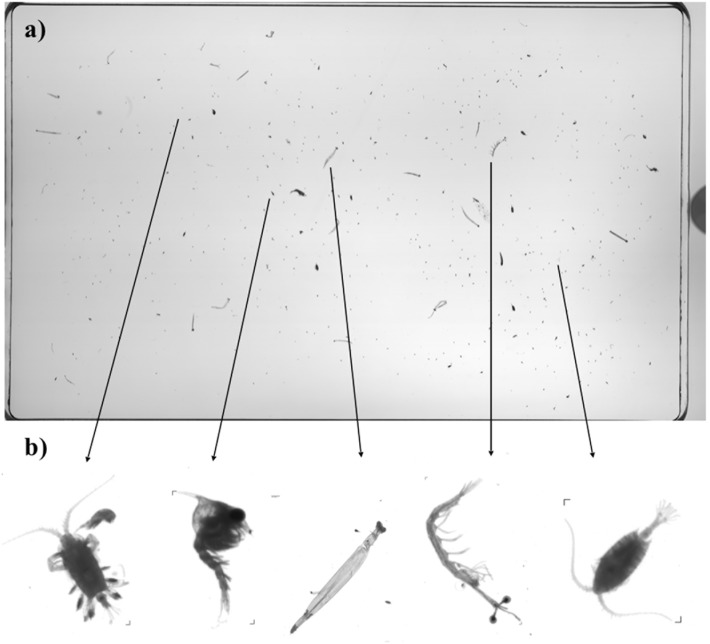
ZooScan system analysis and output.Using ZooScan to measure the size and composition of zooplankton at Lady Elliot Island: a) Scanned image of a zooplankton subsample, and b) examples of digitally-separated vignettes.